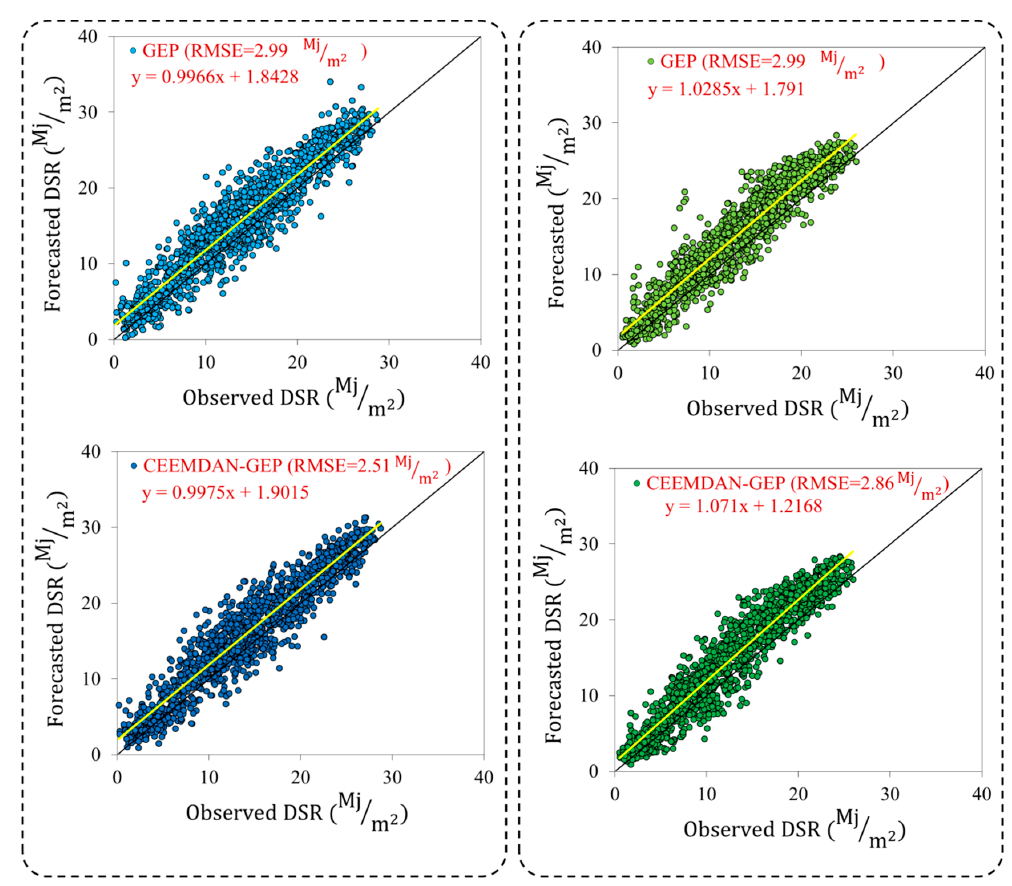
Figure 4. Scatterplots of observed and forecasted DSR using the GEP and CEEMDAN-GEP models in validation phase at Busan (blue color) and Incheon (Green color) stations.